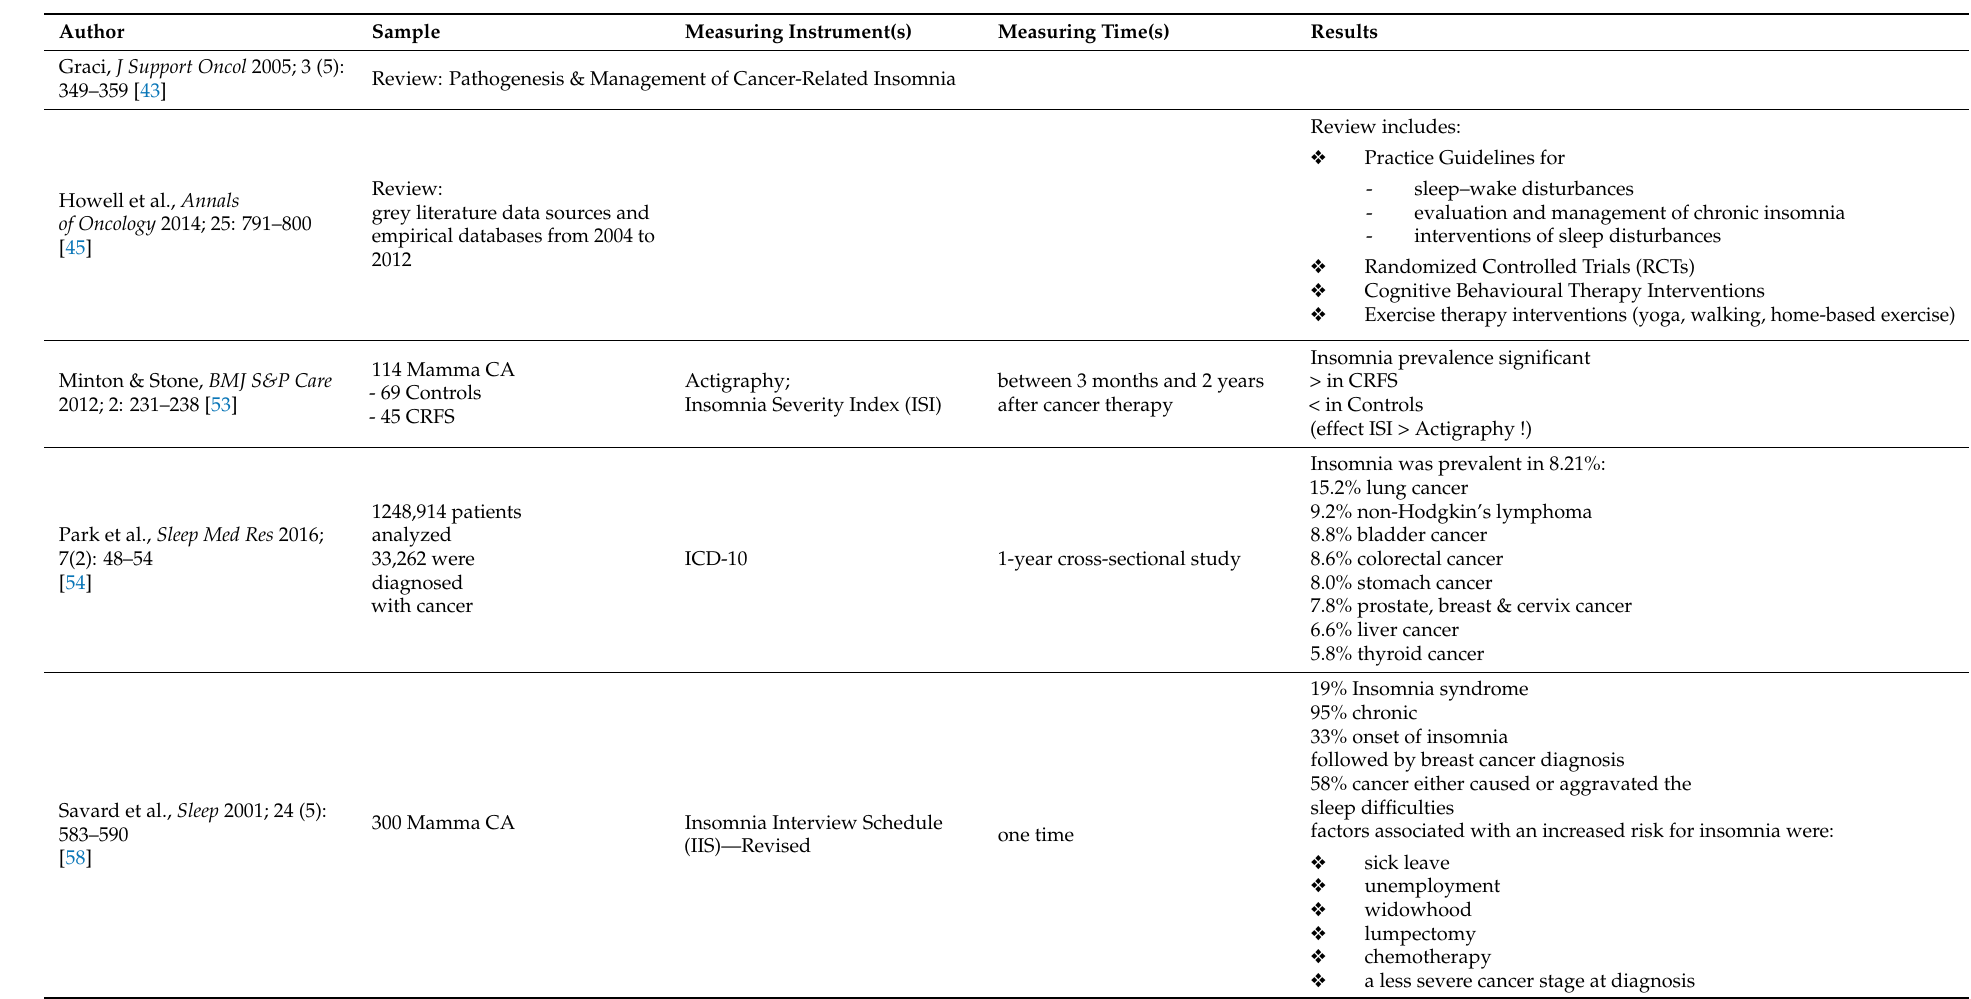
Table 4. Studies on Insomnia in